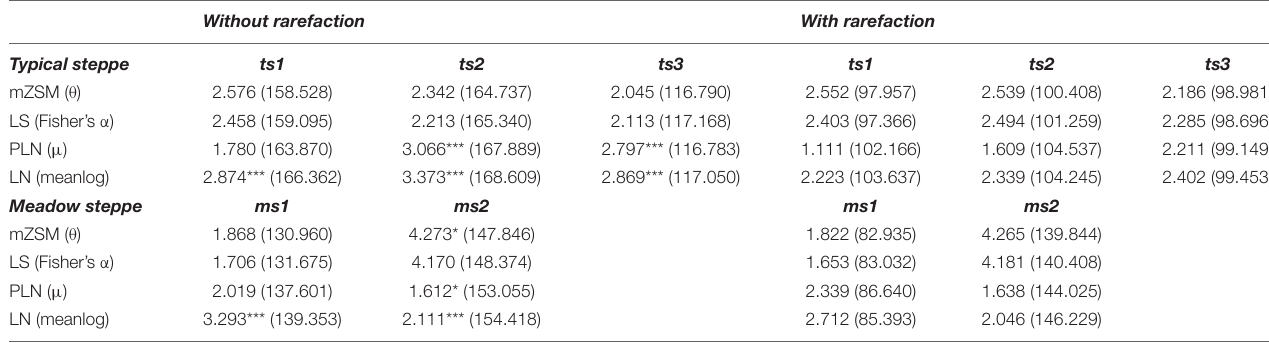
TABLE 3 | Model selection results for the species abundance distributions of carabid beetles in various types of Chinese steppes. Without rarefaction With